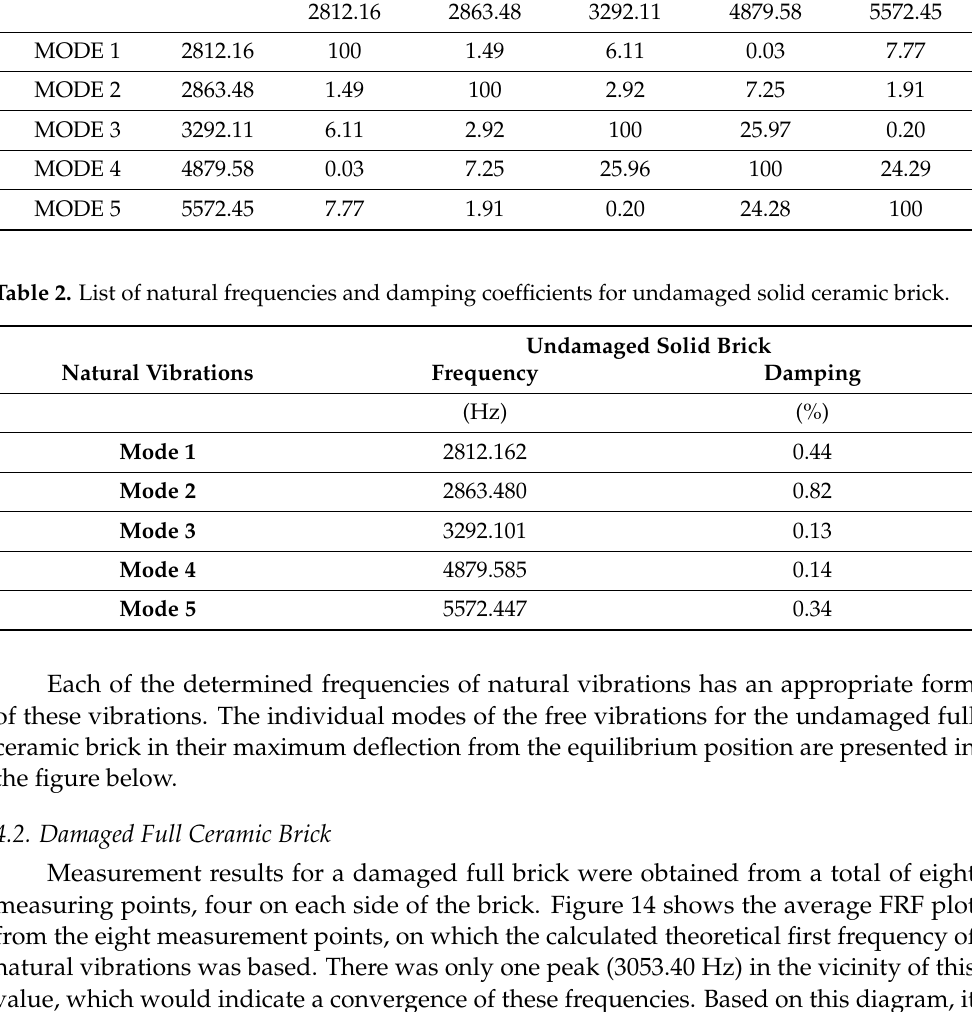
Figure 13. Stabilization diagram created with the use of the SUM indicator from eight measurement points for a damaged full brick because of the compressive strength test. To confirm the selected stable poles, which presumably may be structural vibrations of a solid brick, validation of the selected poles and the corresponding forms of free vibra- tion should be performed. The validation was carried out using the AutoMAC function, the results of which, in relation to the analyzed object, are shown in Figure 14. On this basis, six characteristic modes of free vibration of the damaged full ceramic brick were selected, which are summarized in Table 3. List of natural frequencies and damping coef- ficients are shown in Table 4.